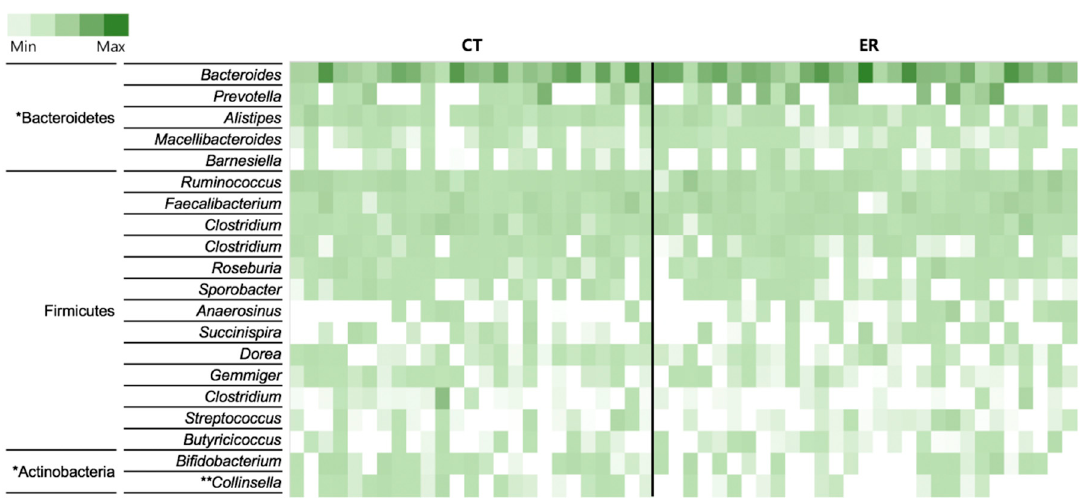
Figure 2. Heat map of the 20 most abundant genera in each sample. The color intensity in each cell indicates the proportion of a given genus in a sample. Significantly abundant taxa in either of the two groups (* p < 0.05, Wilcoxon rank-sum test; ** p < 0.01, Wilcoxon rank-sum test) are